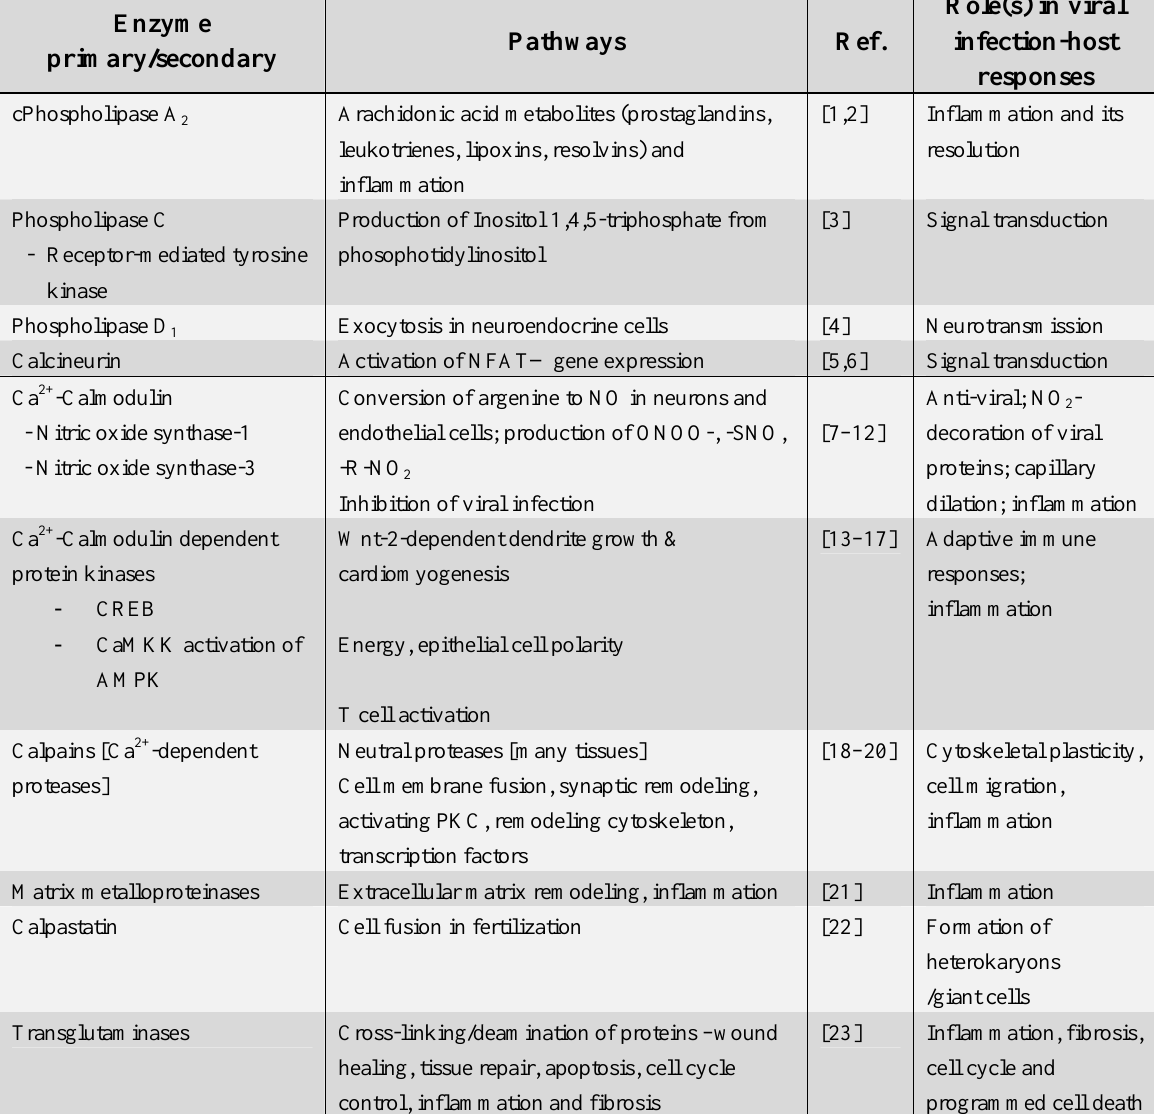
Table 1. Some Ca 2+ -dependent enzymes which may be inhibited by Cannabinoids and speculated role in host responses relevant for viral